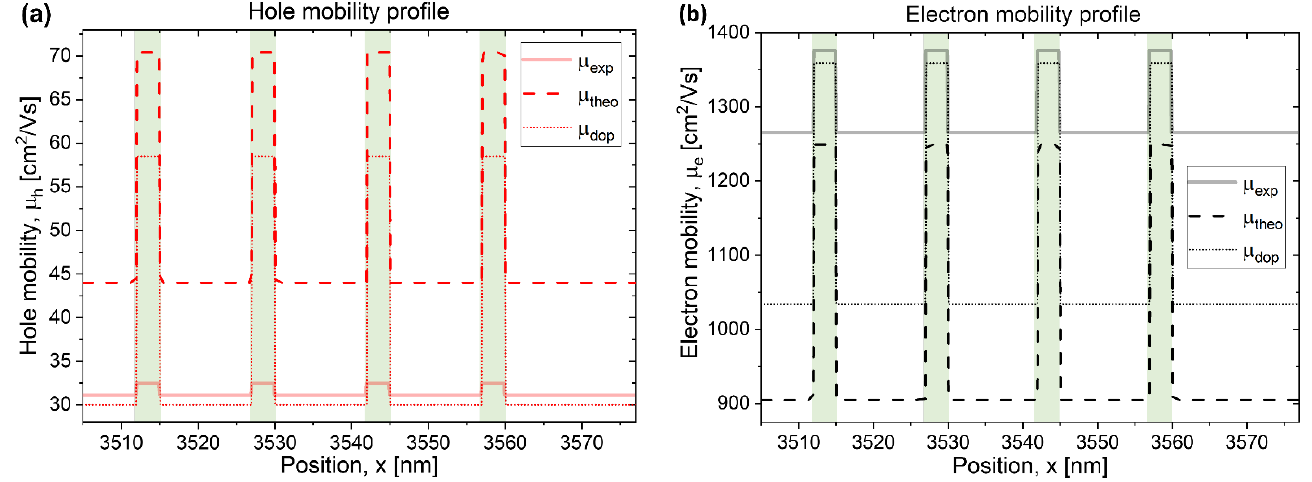
Figure 3. ( a ) Hole and ( b ) electron mobility profile according to Equation (1) using a constant low-field mobility model for the simulated LED.